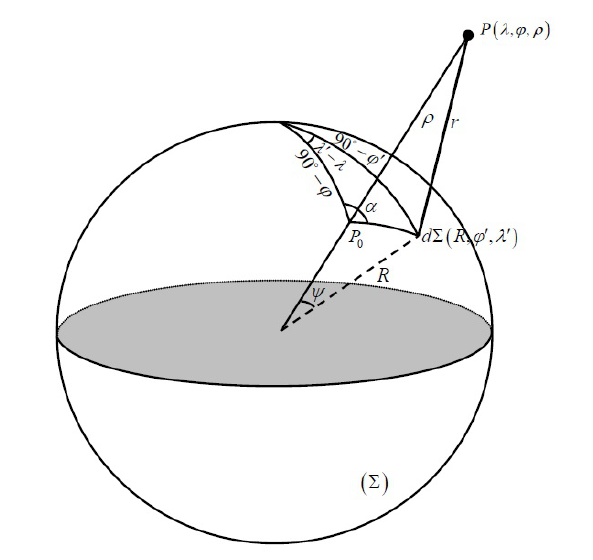
Fig. 2. Variables in the Stokes